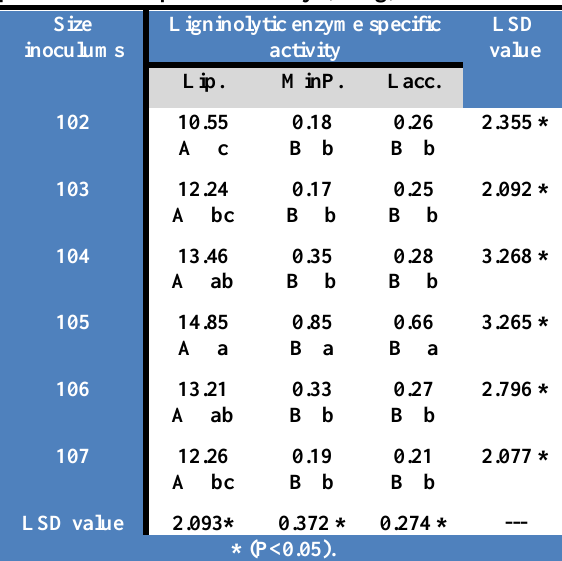
Table, 8: Effect of Size inoculums and enzymes production in specific activity (U/mg).